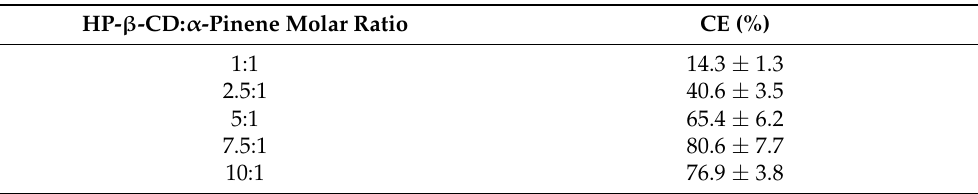
Table 1. The complexation efficiency of α -pinene into HP- β -CD as a function of HP- β -CD: α -pinene molar